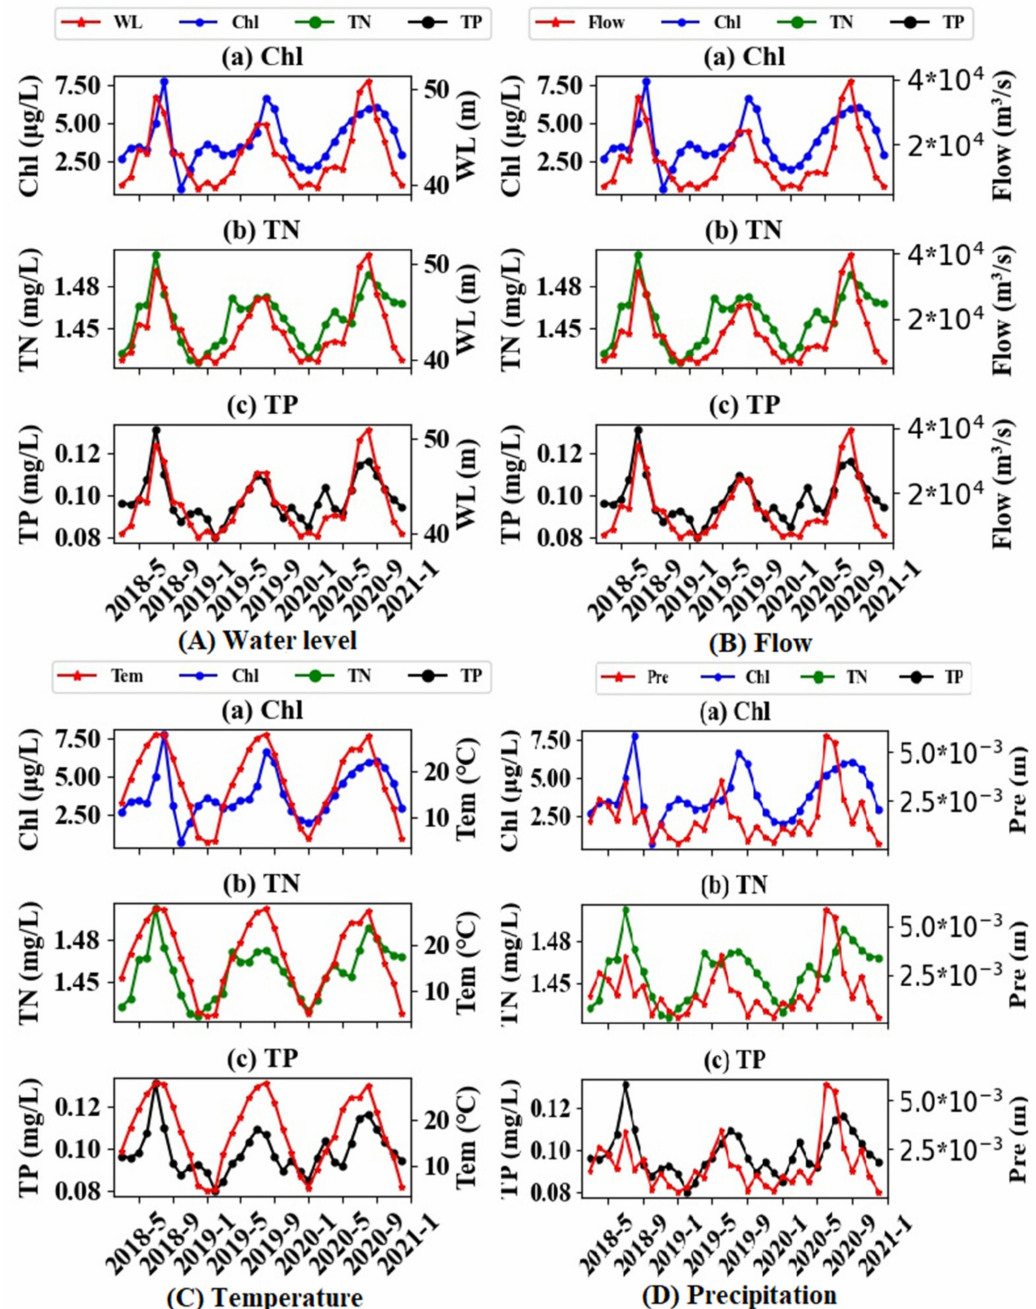
Figure 9. Comparison of Chl-a, TN, and TP concentrations and the variations of different factors. ( A ) is water level, ( B ) is flow, ( C ) is temperature, and ( D ) is